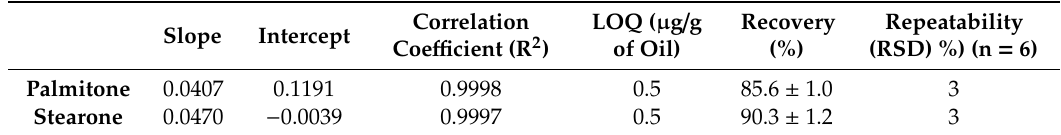
Table 1. Calibration curve in olive oil.